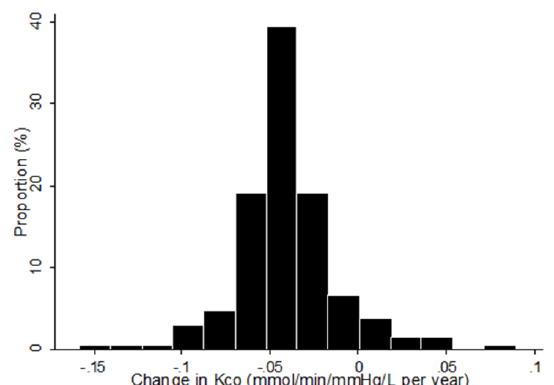
Figure 2. Distribution of estimated annual rates of change in Kco ( n = 211). Footnotes: Best Linear Unbiased Prediction (BLUP) of the annual change in Kco was calculated for each patient using the random-coefficient model, and the data are shown as a histogram. Mean ± SD = −0.04 ± 0.03 (mmol/min/mmHg/L per year).